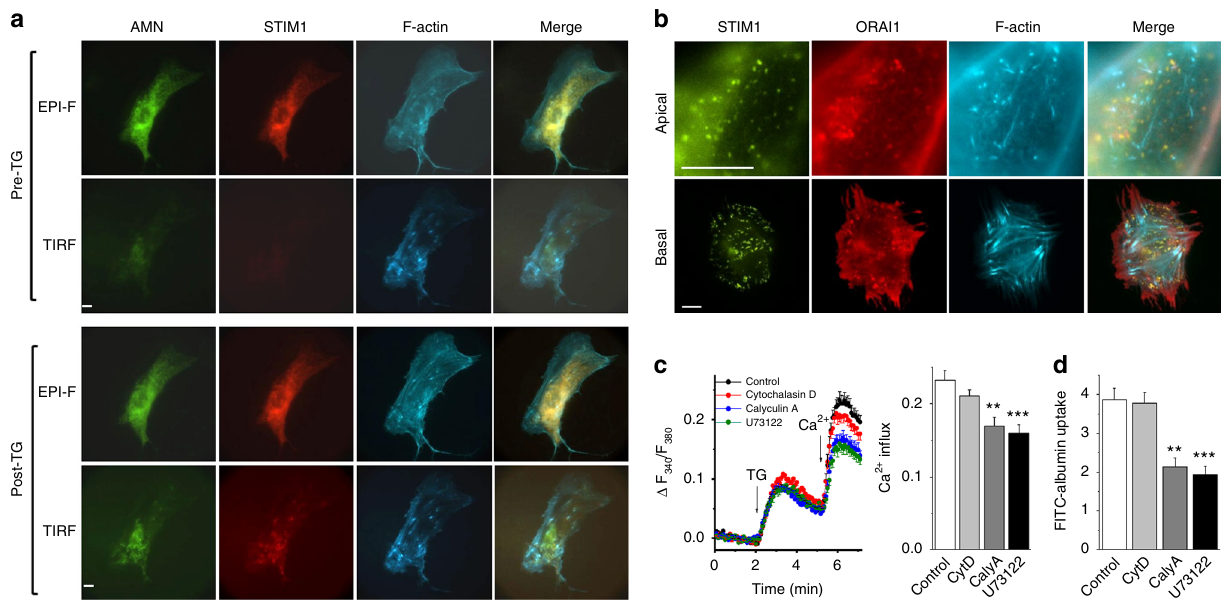
Fig. 7 Subcellular localization of AMN, STIM1, and F-actin and the role of F-actin in albumin uptake and SOCE. a Images taken using Epi-Fluorescence (EPI- F) and TIRF before (pre-TG) and after 1 µ M TG treatment for 10 min (post-TG). AMN tagged with EYFP (AMN-EYFP, green) and STIM1 tagged with mCherry (STIM1-Cherry, red). Subplasmalemmal distribution of F-actin was examined by transfecting PTECs with Lifeact-CFP to label F-actin. b Localization of STIM1-EYFP, mCherry-ORAI1 and F-actin at the apical and basal membranes after Ca 2+ store depletion. Scale bars, 10 µ m. c In fl uence of cytochalasin D (CytD, 10 μ M to depolymerize F-actin, n = 19), calyculin A (CalyA, 10 nM, to increase cortical F-actin content, n = 14) and U73122 (10 μ M, to increase F-actin, n = 13) on store-operated Ca 2+ in fl ux ( n = 12 in control group). Cells were pre-incubated with each drug for 30 min. d FITC-albumin uptake by PTECs was measured after pre-incubation with each drug for 30 min ( n = 6 for each group). Average data are presented as mean ± s.e.m. The data sets are compared by ANOVA. Statistical signi fi cance is indicated by ** P < 0.01, *** P <